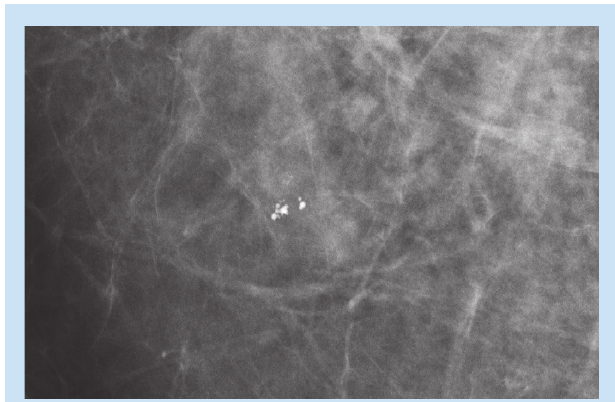
Fig. 2. Patient 2 – pleomorphic calcifications, well circumscribed; calcification pattern is benign.